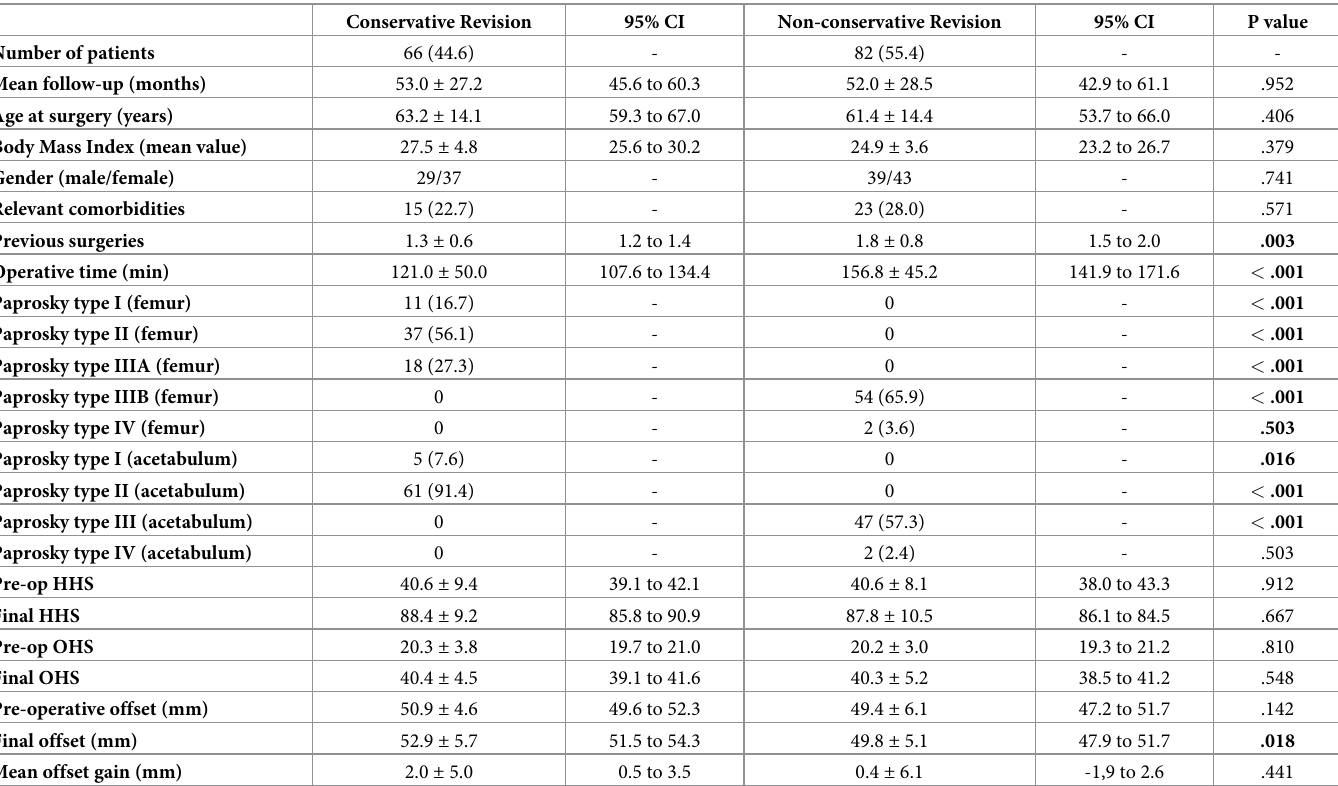
Patients with isolated acetabular revision components had lower final OHS scores than patients with primary components (p = .009), revision stems (p = .016) and acetabular and femoral revision components (p = .036). (Fig